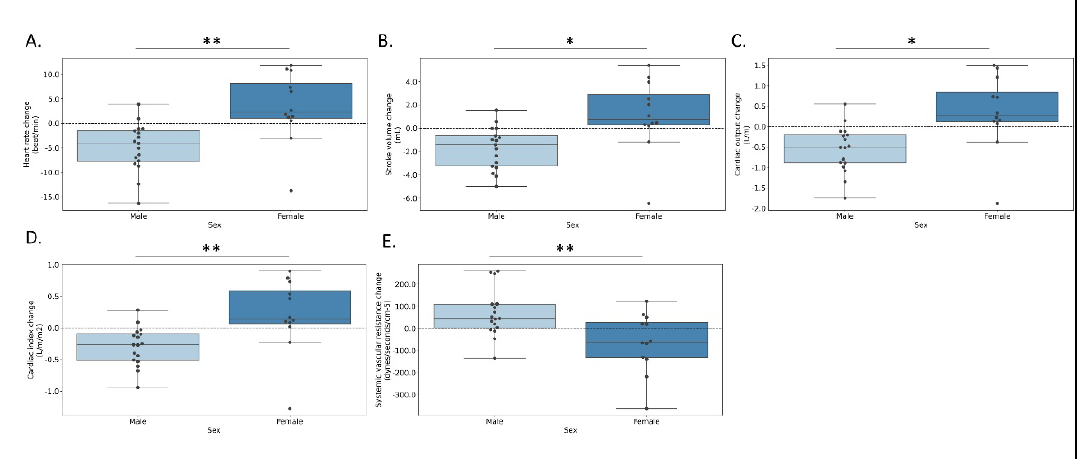
Figure 4. Significant relative changes from baseline in measured parameters from baseline to the fourth quartile of intravenous treatment stratified by sex. ( A ) heart rate (beats per minute), ( B ) stroke volume (milliliters), ( C ) systemic vascular resistance (dynes/sec/cm − 5 ), ( D ) cardiac output (liter/minute), ( E ) cardiac index (liter/minute/body surface area). * p < 0.05, ** p < 0.01.